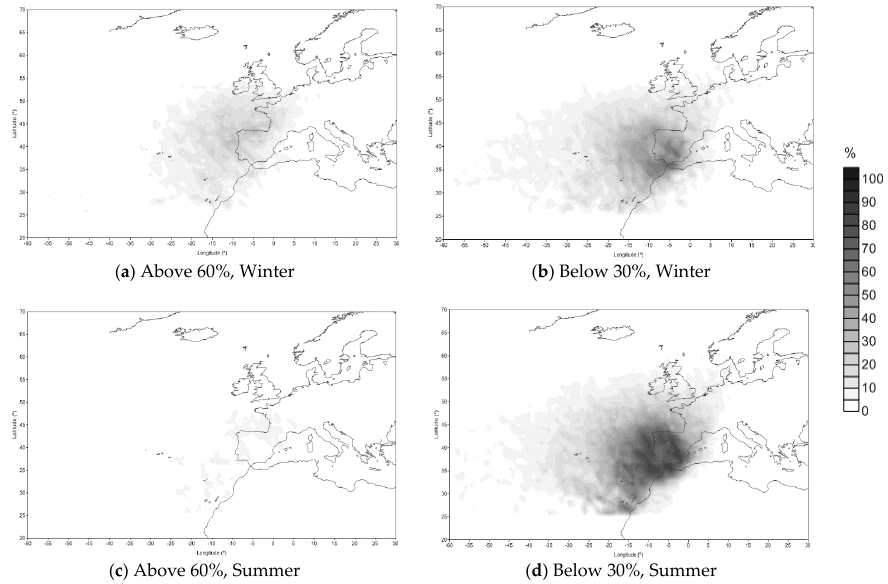
Figure 2. Composite analysis for Methodology 1 for all events with a production ( a ) higher than 60% of the installed capacity for Winter ( b ) lower than 30% of the installed capacity for Winter ( c ) higher than 60% of the installed capacity for Summer ( d ) lower than 30% of the installed capacity for Summer. The TC values are 364 and 384 for the Winter and Summer period, respectively.